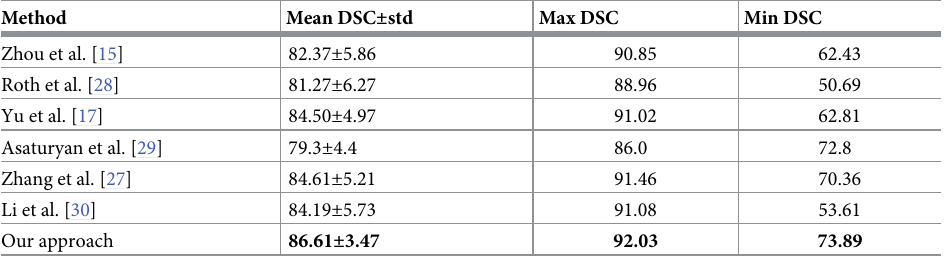
Table 2. Comparison between our approach and the state-of-the-art approaches on NIH pancreas dataset. Method